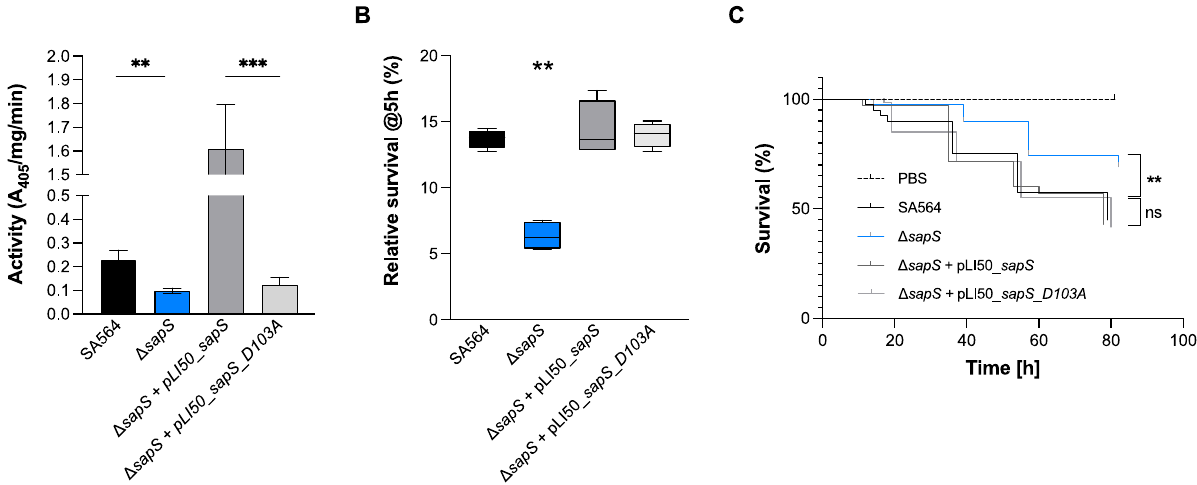
Figure 11. SapS phosphatase activity depends on the D103 residue and is neither implicated in the intramacrophage survival potential nor infectivity of S. aureus in zebrafish. ( A ) Cells of S. aureus SA564 (black), SA564 ∆ sapS (blue), SA564 ∆ sapS + pLI50_SapS-Spot (dark grey) and SA564 ∆ sapS + pLI50_SapS_D103A-Spot (light grey) were grown in TSB at 37 ◦ C until exponential phase, centrifuged, lysed and total crude extracts were used for phosphatase activity assays on PNPP. Data are presented as mean + SD of three biological replicates. **, p < 0.01; *** (Mann–Whitney U test). ( B ) Survival of S. aureus in infected macrophages. Survival rates are expressed as a percentage of the intracellular bacterial cell counts that were obtained immediately after the gentamicin/lysostaphin treatment, which was fixed to 100%. The data are presented as box and whisker plot showing the interquartile range (25–75%, box), the median (horizontal line) and the standard deviation (bars) of 4 different experiments. **, p < 0.01 (Ordinary two-way ANOVA test). ( C ) Kaplan–Meier representation of the survival of zebrafish embryos infected by injection into the duct of Cuvier with at 3 × 10 2 CFU/nL cultured in exponential phase, or PBS (negative control) The proportion of surviving embryos (n = 50 for each, indicative of three separate experiments) is employed to express the results. **, p < 0.01, ns, not significant (Log-rank Mantel–Cox statistical test). hpi, hours